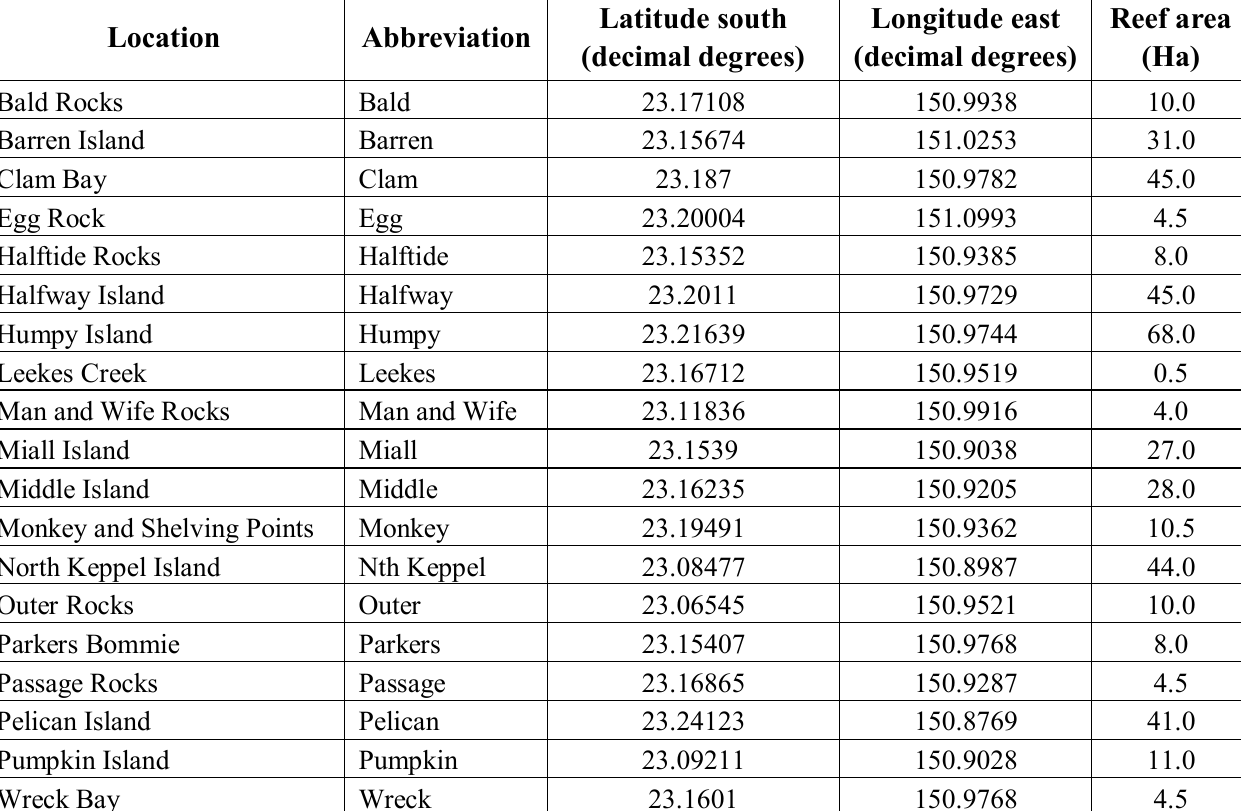
Table 1. The study sites in the Keppels and their